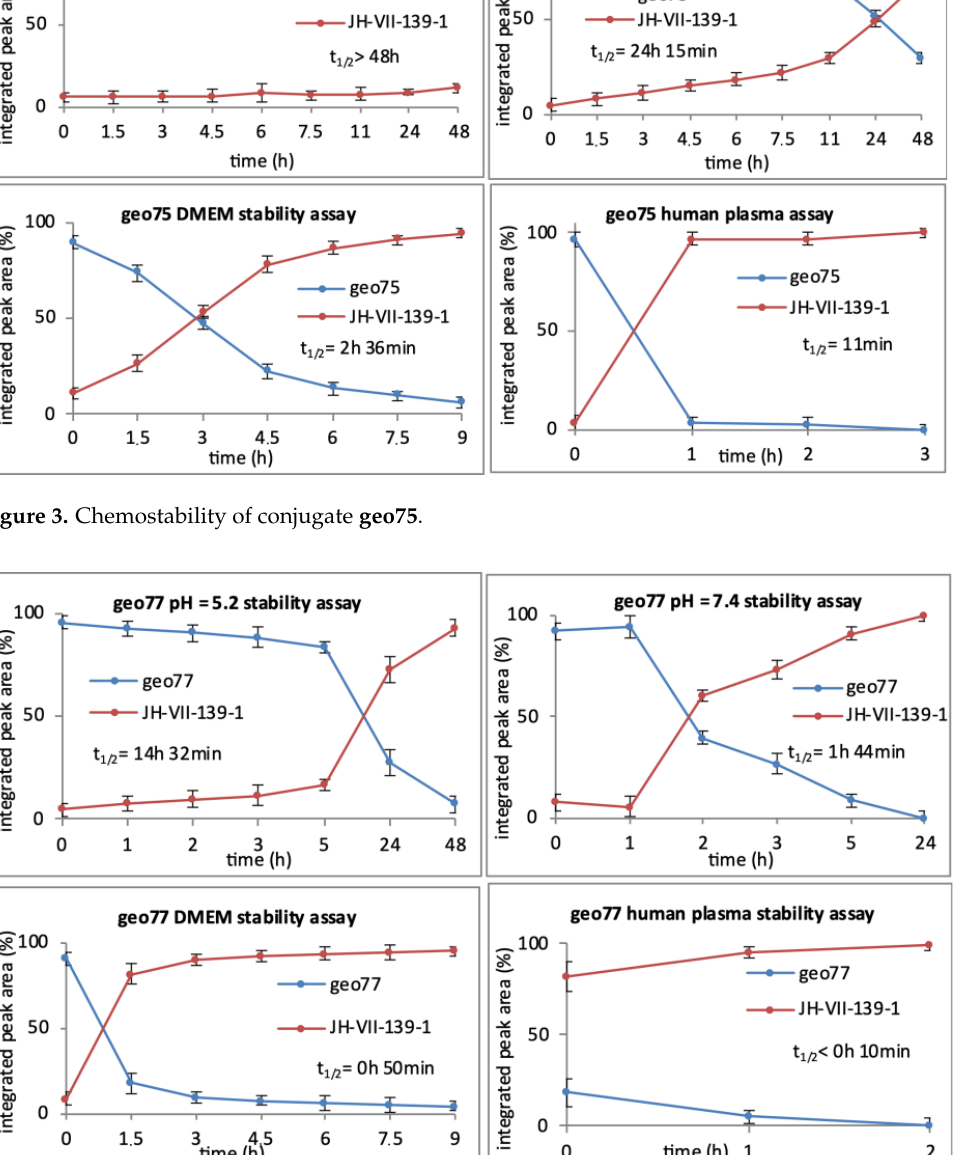
Figure 3. Chemostability of conjugate geo75 .